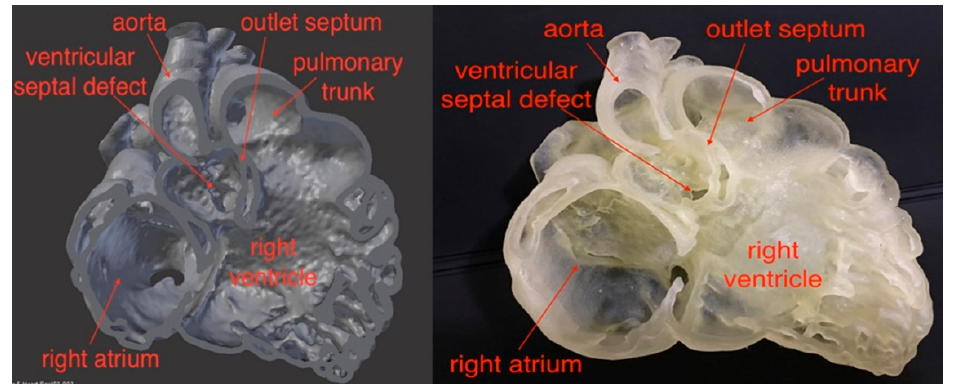
Figure 2. Comparison of virtual 3D reconstruction model (left) and 3D printed heart model (right). Reprinted with permission under the open access from Lau et al. [16].